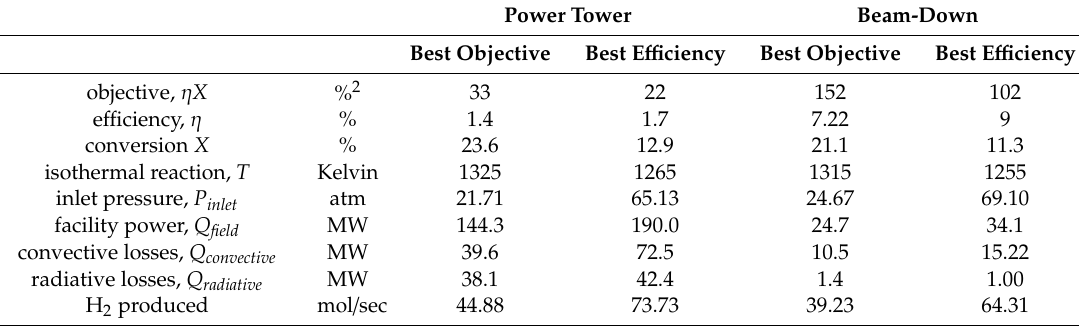
Figure 8. Characteristics of alternative solar facilities for H 2 production. Table 2. The best simulated power tower and beam-down reactor designs across potential operating pressures from 2 to 200 atmospheres and 1150 to 1350 Kelvin.